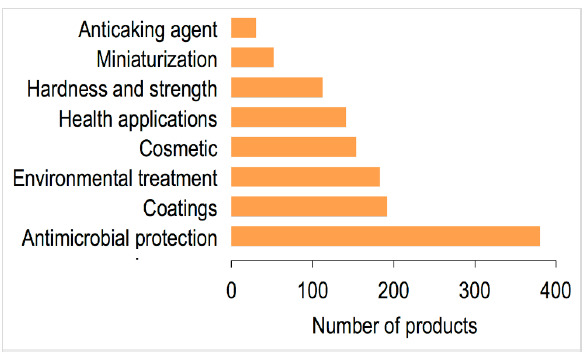
Figure 6: Expected benefits of incorporating nanomaterial additives into consumer products.